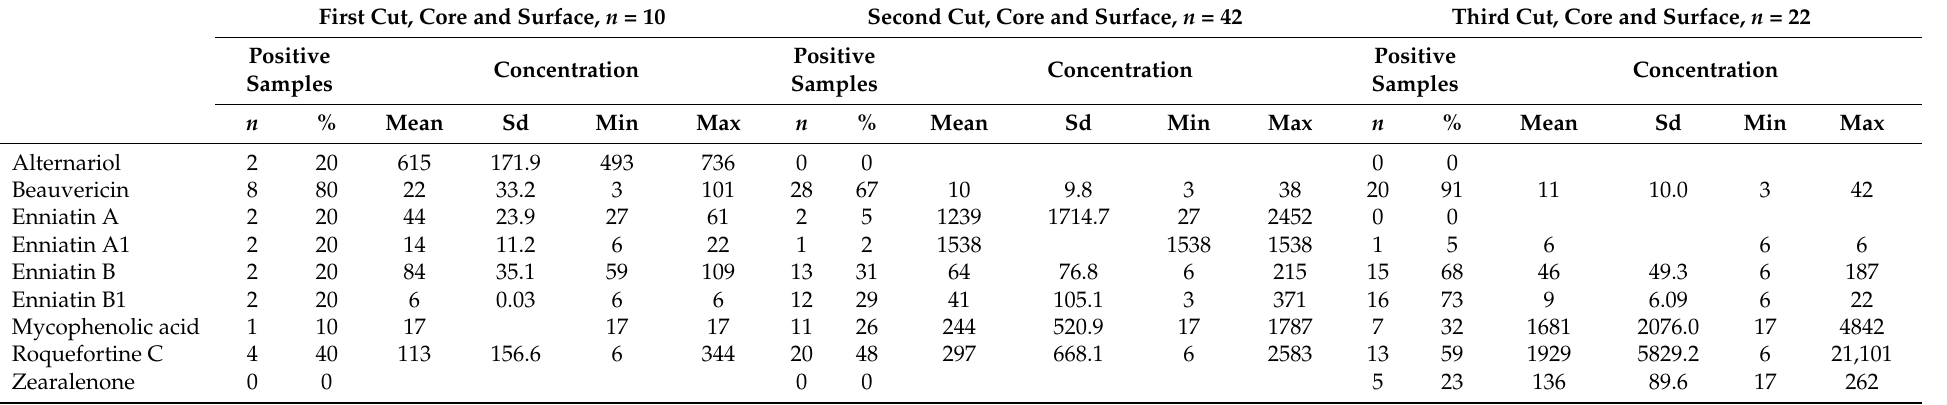
Table 5. Incidence and concentrations ( µ g/kg dry matter) of mycotoxins in different cuts of grass silage. Mouldy samples were not included in the results. Values represent only samples where the specific mycotoxin was